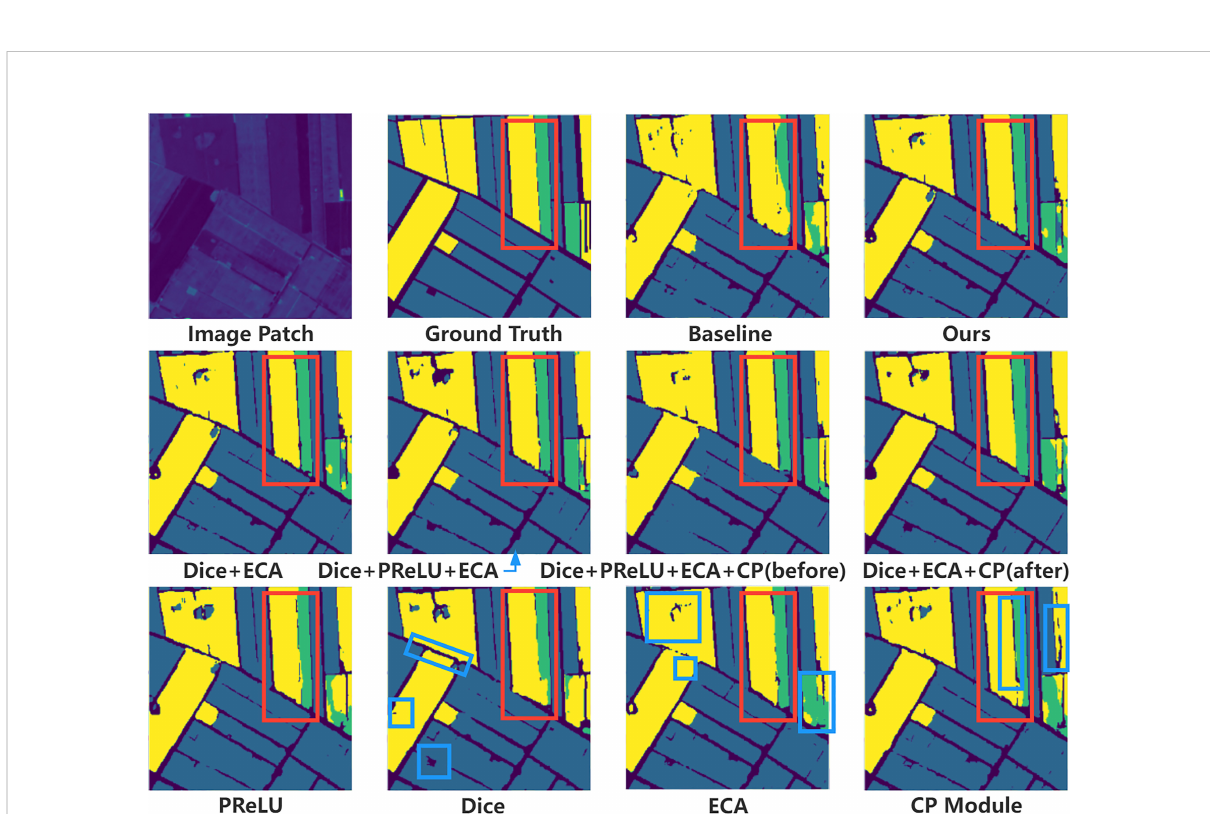
FIGURE 6 Visualization of the predicted results of ablation experiments. This part mainly analyzes the speci fi c impact of adding and deleting different modules on the performance of the model. The second line of the image shows the common in fl uence of different modules on the prediction results, and the third line shows the speci fi c in fl uence of each module on the prediction results. Among them, the red box shows the areas where our method is superior to other methods, and the blue box shows the areas where each module improves the baseline network.